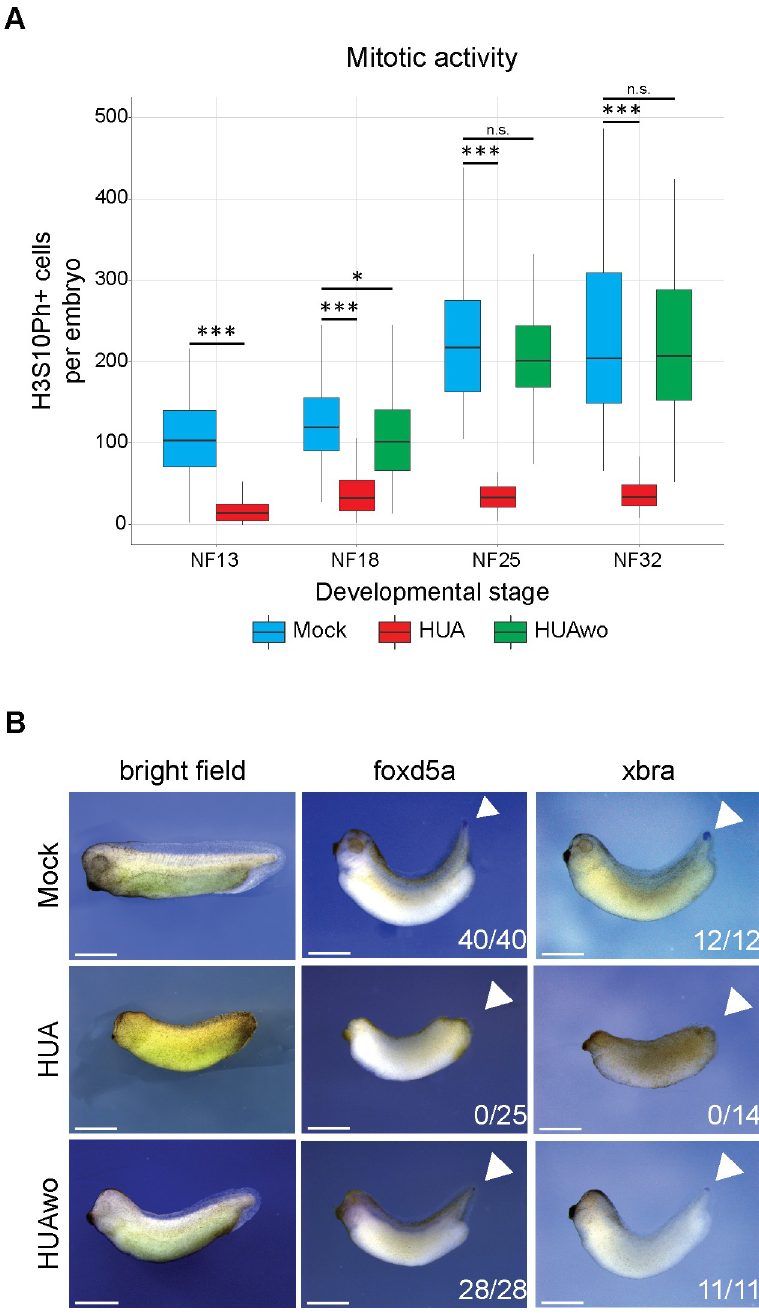
Fig 5. The HUA effects on embryogenesis are reversible. Embryos, which were transiently incubated in HUA solution and thus mitotically arrested, were returned to Mock solution at NF13. (A) Abundance of mitotic cells in Mock, HUA-treated, and HUAwo embryos. Box plots based on H3S10Ph-positive cells present on the recorded surface of embryos, displayed in S5 Fig (n � 3 biological replicates/condition; Student t test [unpaired, two-tailed]; ��� p < 0.001; � p < 0.05; n.s., not significant). The individual quantitative observations can be found in S3 Data. (B) Morphological and molecular features of embryos at the early tadpole stage. In contrast to continuous HUA-treated embryos, HUAwo embryos regain eye cups, fin, and tailbud structures. In addition, they express foxd5a and xbra mRNAs in the growth zone of the tailbud, comparable to Mock embryos. Numbers indicate embryos positive for the marker over the total number of analyzed embryos ( n = 3 biological replicates/condition). Scale bars: 1 mm. HUA, hydroxyurea and aphidicolin; HUAwo, HUA washout.